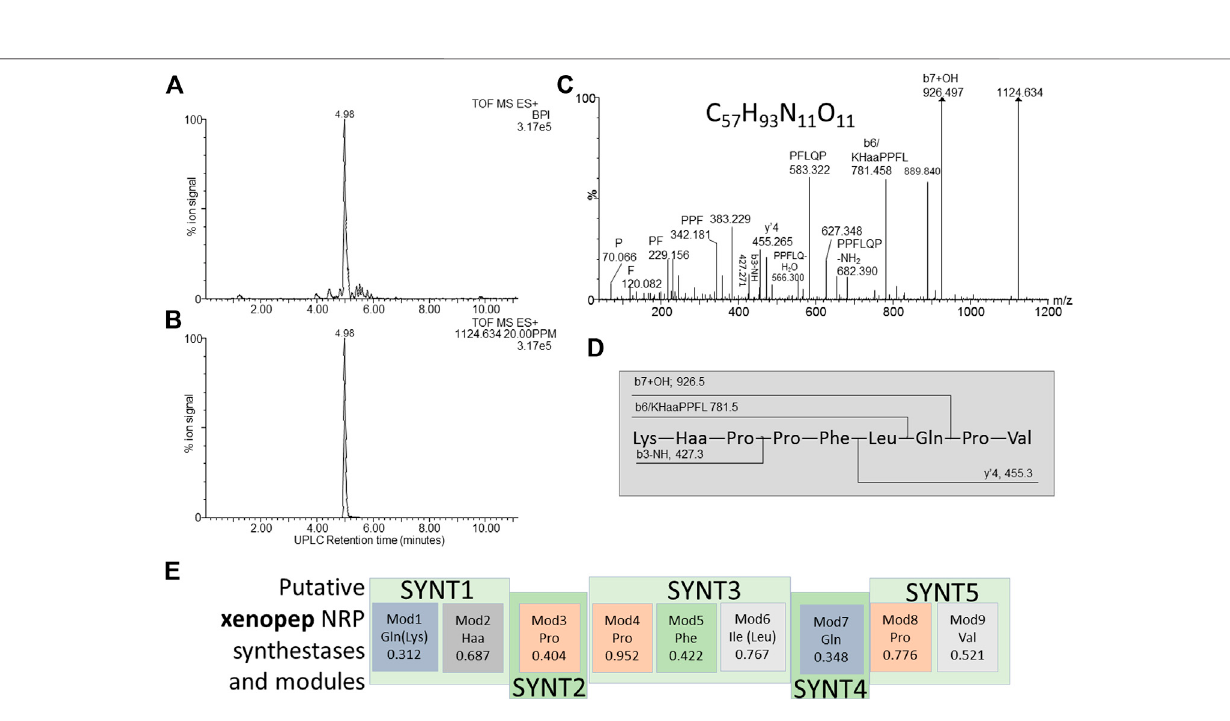
Frontiers in Chemistry |